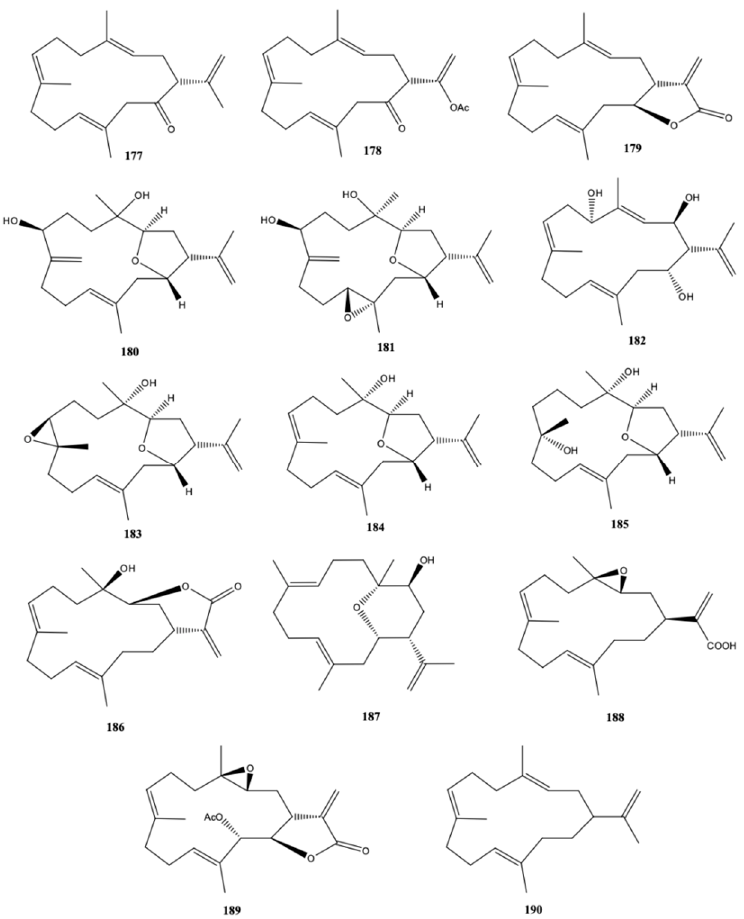
Figure 15. Cembranoid diterpenes from wild Lobophytum crassum from China (South China Sea and Twain) [9,54–56] and from aquaculture L. crassum [57].